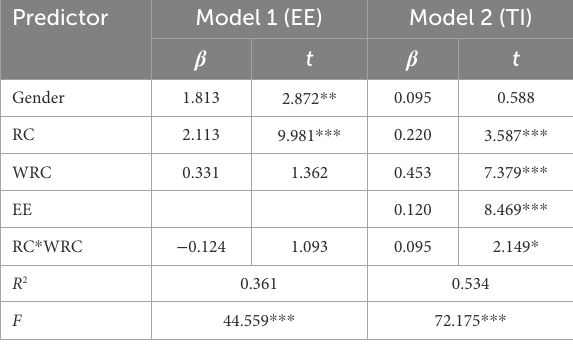
TABLE 5 Testing the moderated mediation effect of role conflict on turnover intension.